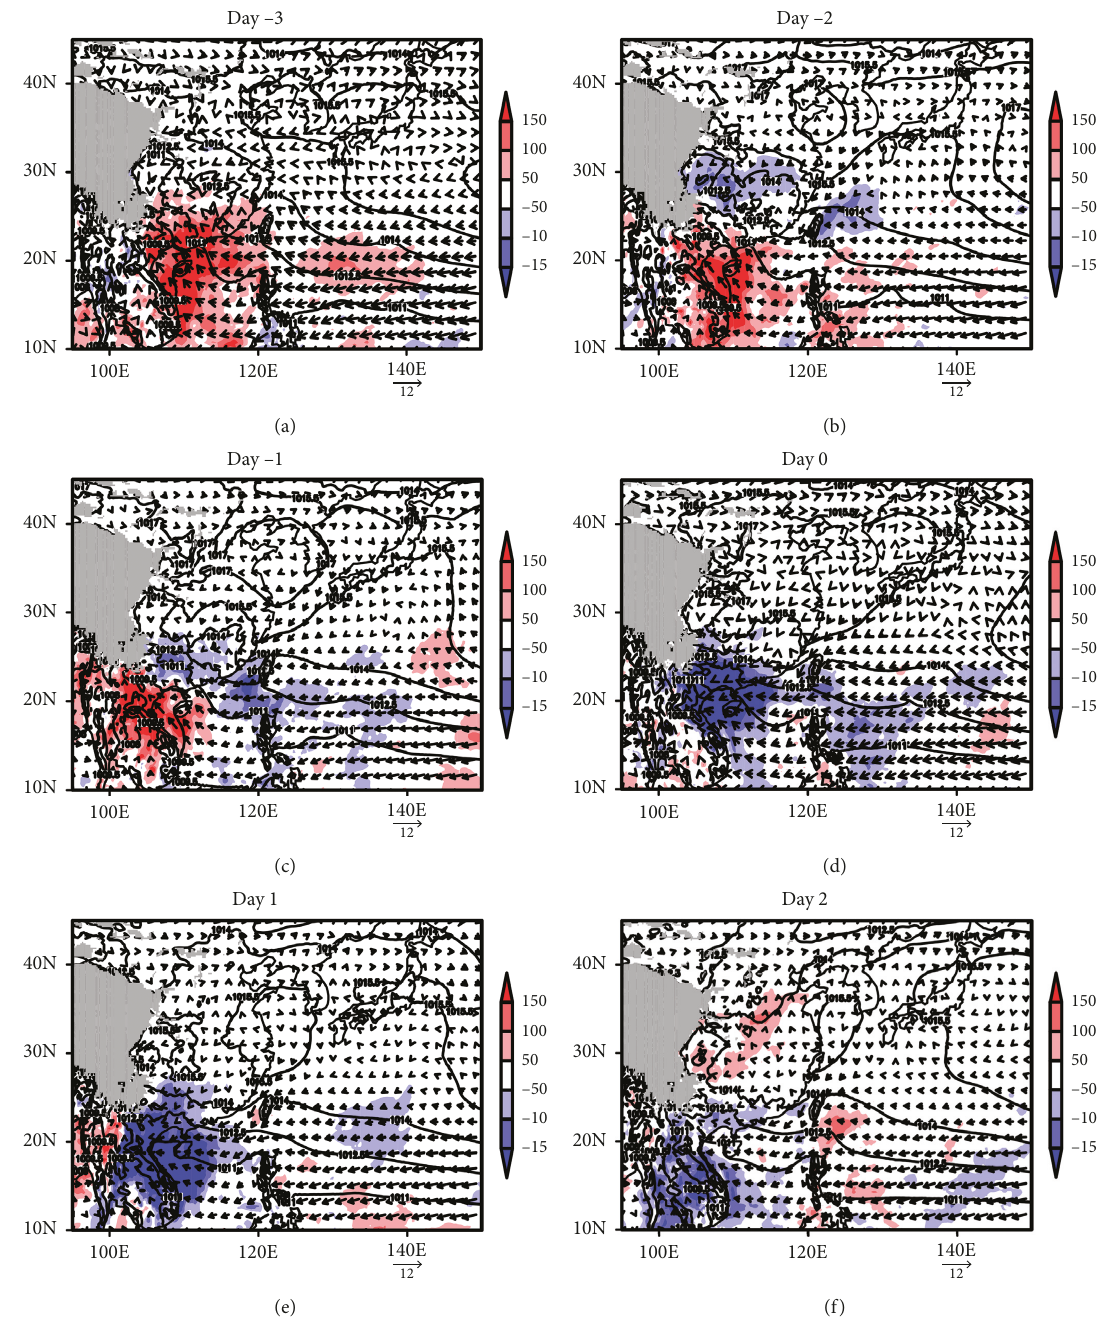
Figure 7: 10m wind ( vector , ms − 1 ), mean sea level pressure ( contour , m), and time rate change CAPE ( shaded , Jkg − 1 ) during the events associated with cold surge and low-level vortex. The areas where the land elevation is higher than 1500m are shaded